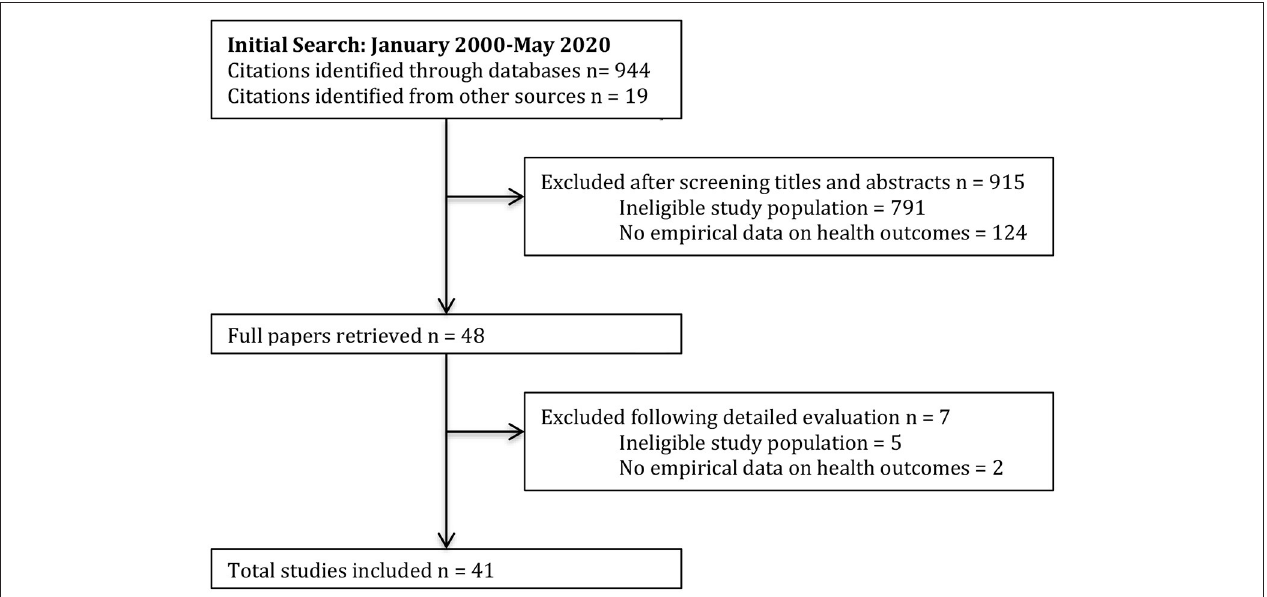
FIGURE 1 | Flow diagram of study selection adapted from “Preferred items for systematic reviews and meta-analyses: the PRISMA statement,” by Moher et al. (32), PLoS Medicine, 6(7).